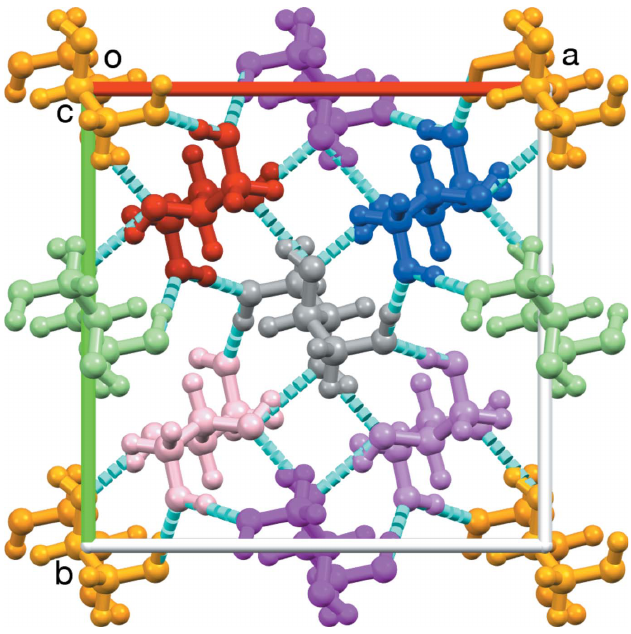
Figure 9 Crystal packing of erythritol viewed along the c axis. O—H (cid:6)(cid:6)(cid:6) O hydrogen bonds are shown as blue dashed lines [generated with Mercury (Macrae et al. ,